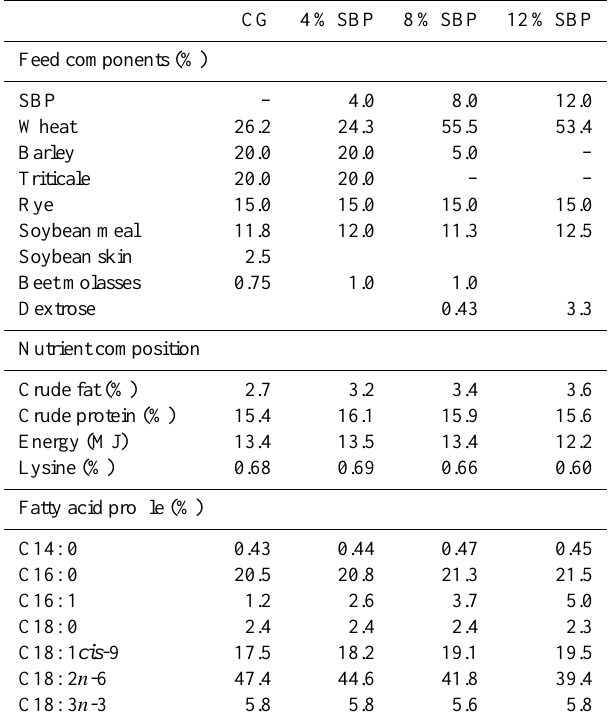
Table 3. Feed components, chemical and fatty acid composition of the rations.